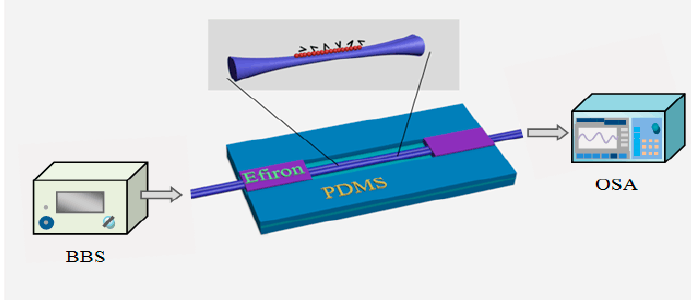
Figure 27. Schematic diagram of the experimental setup for MFC structure.